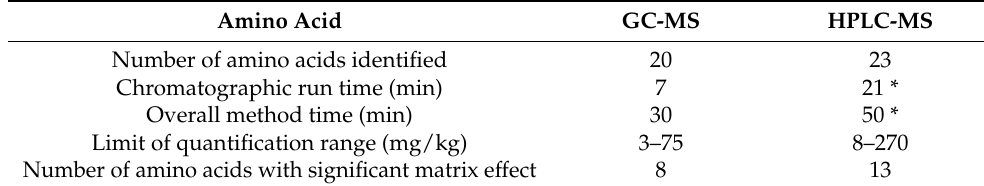
Table 5. Comparison of the GC-MS and HPLC-MS